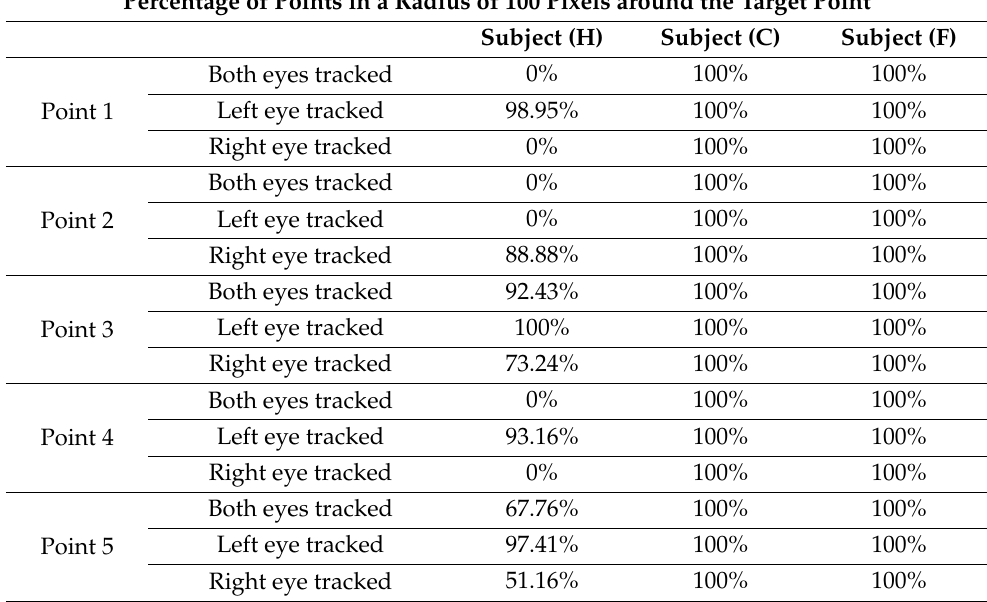
Table 3. Percentage of points in a radius of 100 pixels around the target